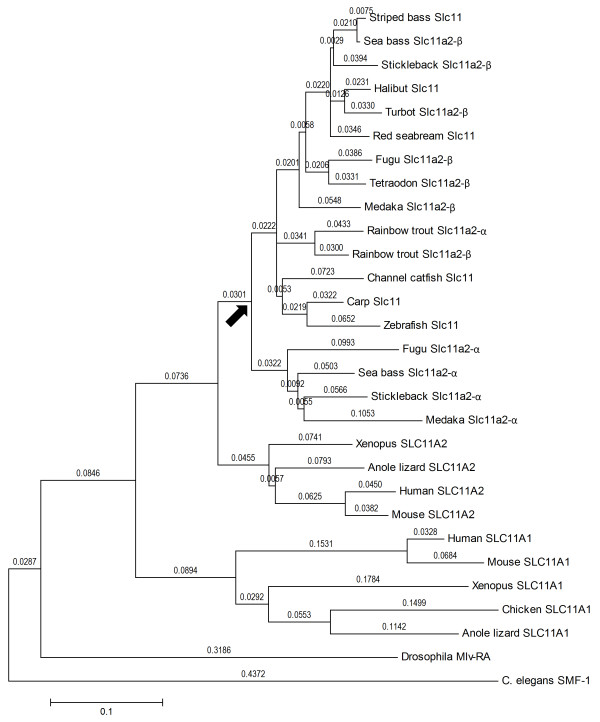
Molecular Phylogenetic analysis by Maximum Likelihood method. The evolutionary history was inferred by using the Maximum Likelihood method based on the JTT matrix-based model. The bootstrap consensus tree inferred from 1000 replicates is taken to represent the evolutionary history of the taxa analyzed. Initial tree(s) for the heuristic search were obtained automatically as follows. When the number of common sites was < 100 or less than one fourth of the total number of sites, the maximum parsimony method was used; otherwise BIONJ method with MCL distance matrix was used. The tree is drawn to scale, with branch lengths measured in the number of substitutions per site (above the branches). The analysis involved 29 amino acid sequences. All positions containing gaps and missing data were eliminated. There were a total of 408 positions in the final dataset. Arrow indicates the duplication point of α and β isoforms in teleosts.